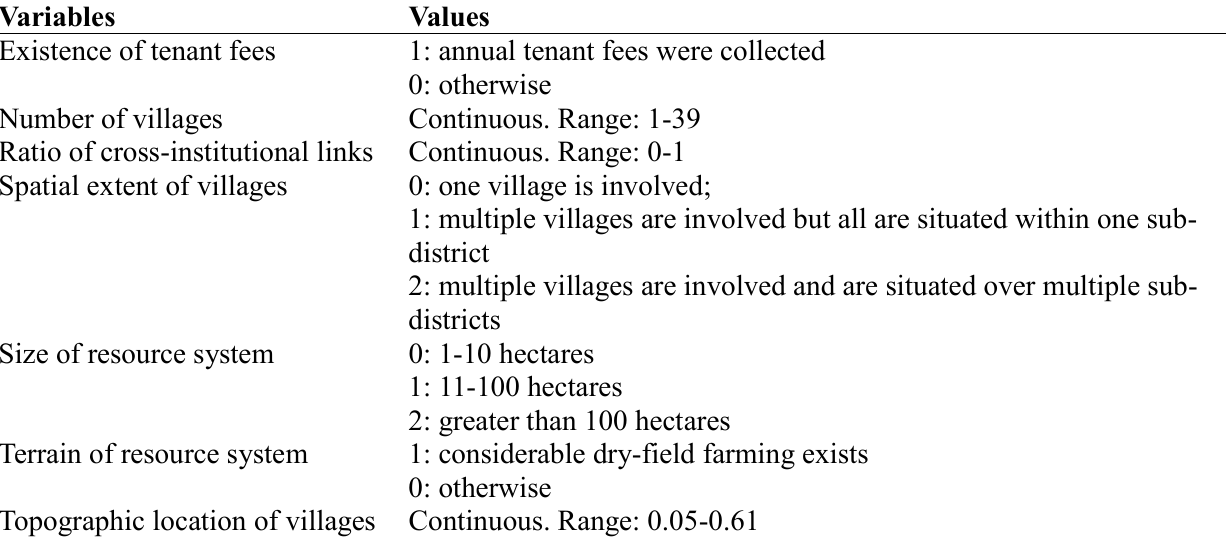
Table A.2. Values of independent